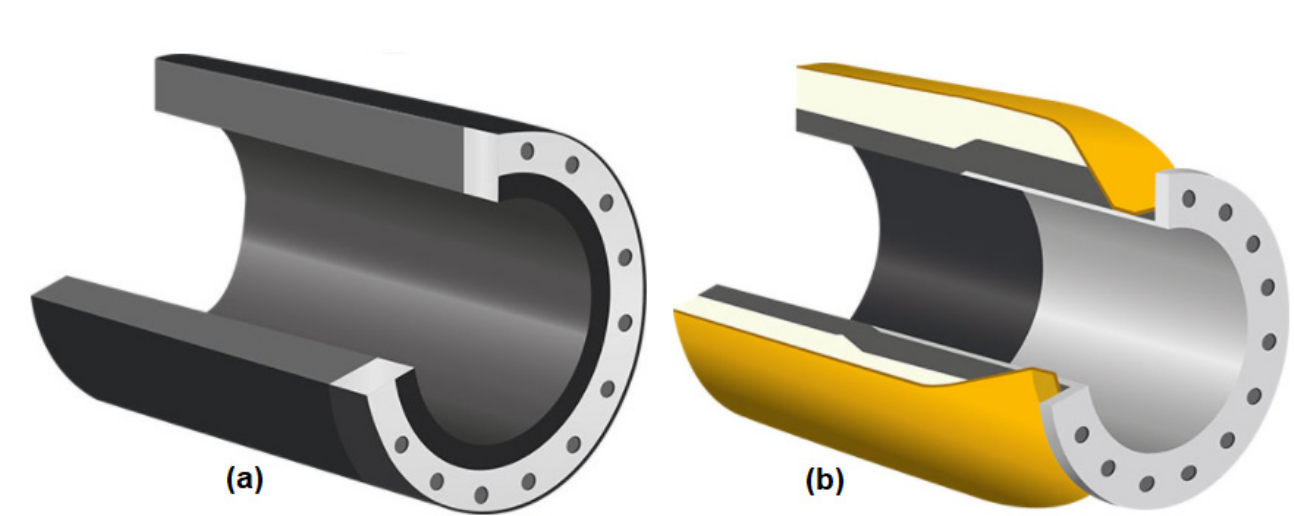
Figure 34. Two different hose fittings showing ( a ) nippleless and ( b ) nipple hose designs.